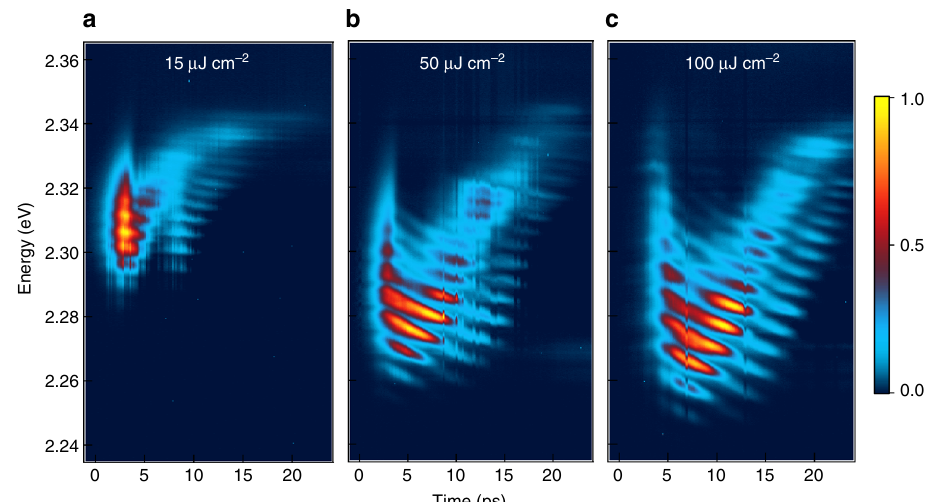
Fig. 3 Time-resolved lasing. The 2D pseudo-color (normalized intensity) plots show emission spectra at a 15, b 50, and c 100 μ J cm − 2 . These powers represent the lasing region before saturation, the saturation region, and the high power limit. Line-cuts and integrated spectra can be found in Supplementary Figure 4. All spectra were obtained from a single NW with 15 µ m length at a substrate temperature of 80